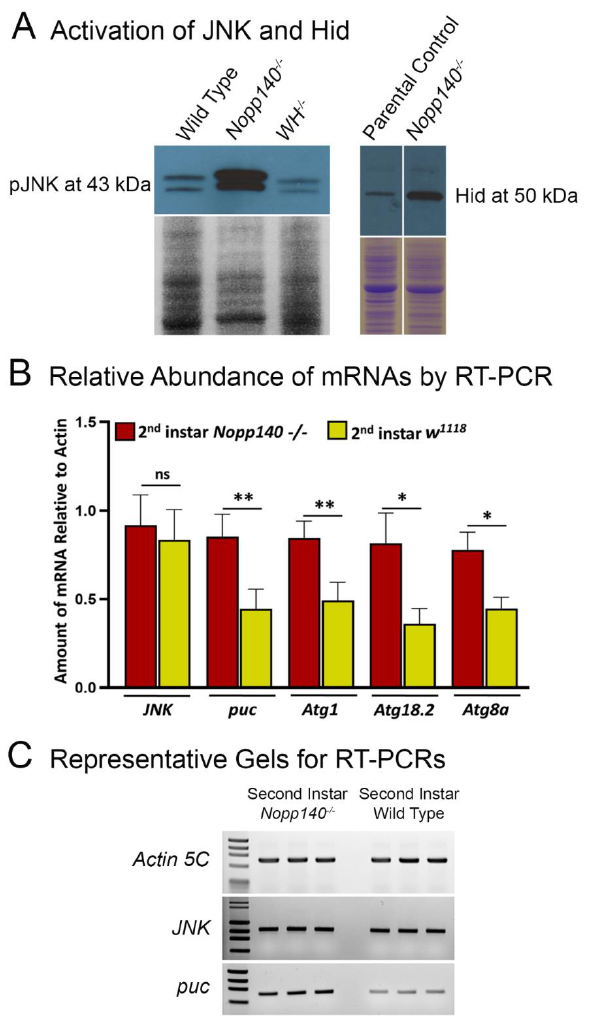
Figure 3. Activation of the JNK pathway in Nopp140-/- knockout larvae. ( A ) The left-hand western blot shows activation of c-Jun N-terminal kinase (JNK) as detected by an antibody against phospho- JNK in KO121 Nopp140-/- larval extracts versus wild type and WH-/- larval extracts. WH- refers to the original fly line containing the pBac element ( f04633 ) with the WH- orientation and located in the 3′ coding sequence of P5CDH1 positioned immediately downstream of Nopp140 and used to delete the Nopp140 gene (see [31]). The right-hand western blot shows accumulation of pro-apoptotic Hid compared to parental controls. JNK phosphorylates AP-1 which then activates the hid gene. Companion Coomassie stained gels are included below each Western blot as loading controls. ( B ) While JNK kinase increased in KO121 Nopp140-/- larvae compared to similarly aged (2nd instar) wild type ( w 1118 ) controls, RT-PCRs showed, as expected, that JNK transcript levels were not significantly different between KO121 Nopp140-/- and wild type ( w 1118 ). Expression of puc is a commonly used indicator of JNK kinase activity. Abundance of autophagy transcripts Atg1 , Atg18.2 , and Atg8a were also elevated. Data are presented as average RT-PCR products of individual transcript levels compared to that of Actin5C . Error bars represent mean ± standard deviation of at least three independent determinations and statistical significance was calculated by a paired Student’s t -test using GraphPad Prism 9.0.1 with p values < 0.05 are indicated (*) and with p values < 0.005 are indicated (**). ( C ) Representative agarose gels show Actin5C (as a standard control), JNK , and puc RT-PCR products. Four independent experiments were performed per gene, and PCR reactions were performed in